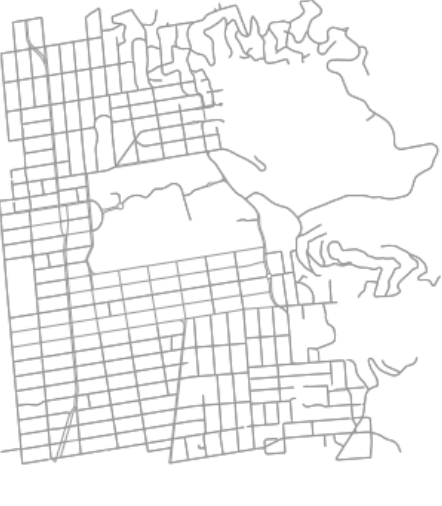
Figure 5: Output from codebox